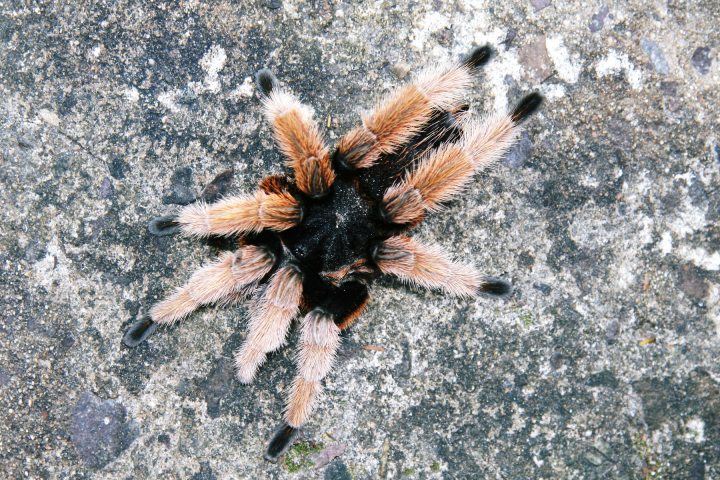
Brachypelma
klaasi (Schmidt & Krause, 1994) male near Chamela, Jalisco state, Mexico. Photo: Andrew M. Smith.